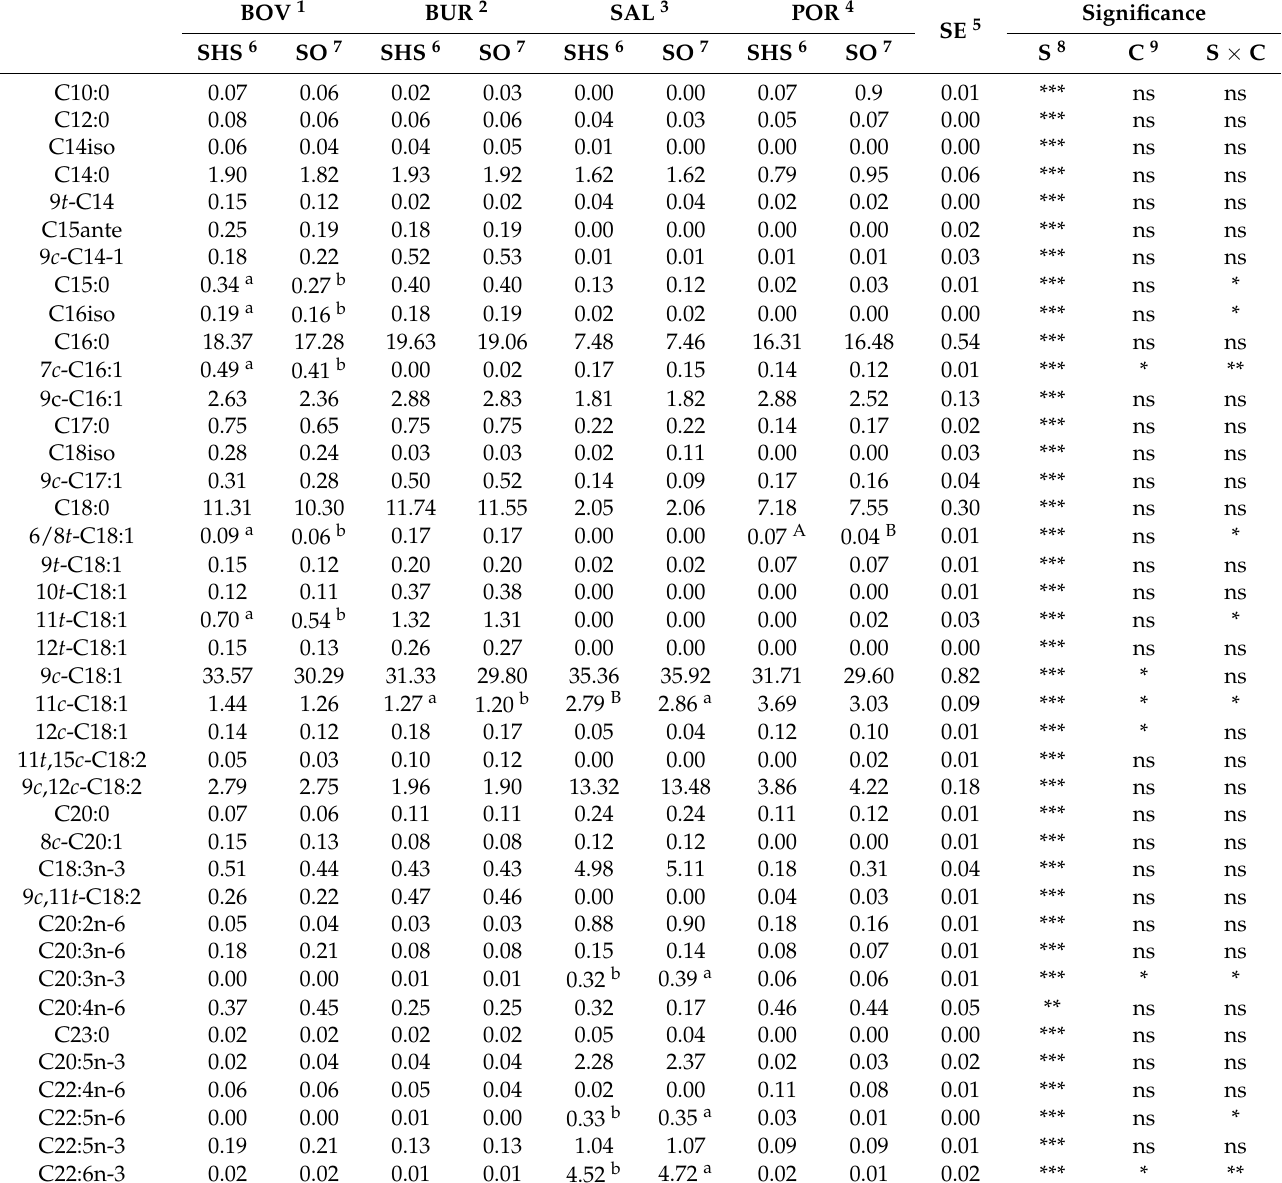
Table 6. Fatty acid composition of different matrices (g/100 g of total lipids).